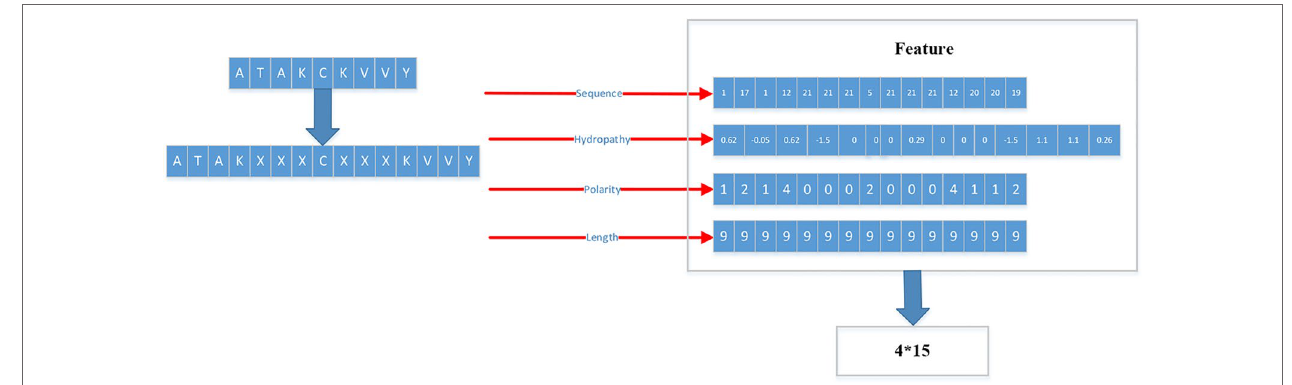
FIgURe 3 | Detailed flow of generating training set and testing